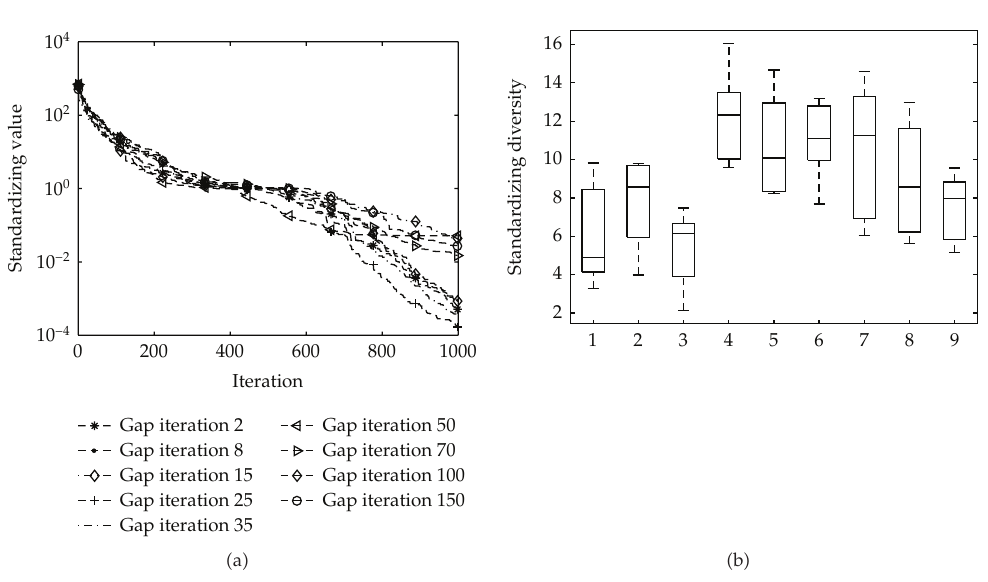
Figure 6: Standardizing mean values and diversity with di ff erent gap iterations (cid:2) n (cid:3)